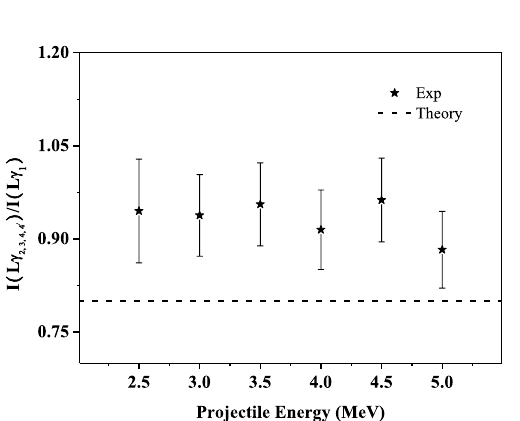
Figure 6. Relative intensity ratios of I Lι to Lβ 2, 15 X-ray as a function of incident energy.